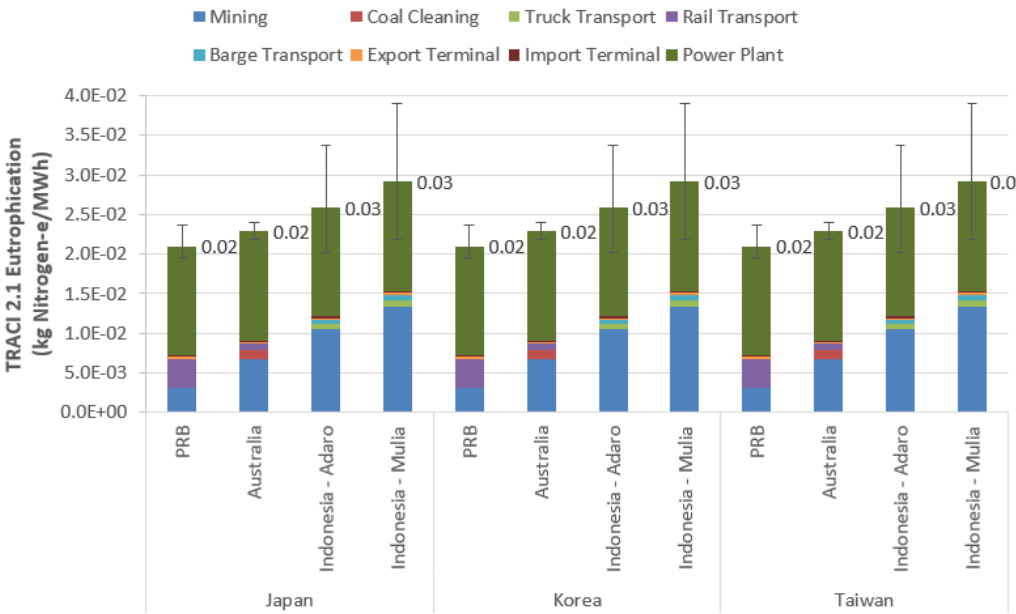
Figure 7. Cradle-to-busbar TRACI 2.1 eutrophication impact category results for U.S. (PRB), Australian (AU), and Indonesian (ID) coals exported to Japan, South Korea (Korea), and Taiwan. Ocean transport impacts are excluded.